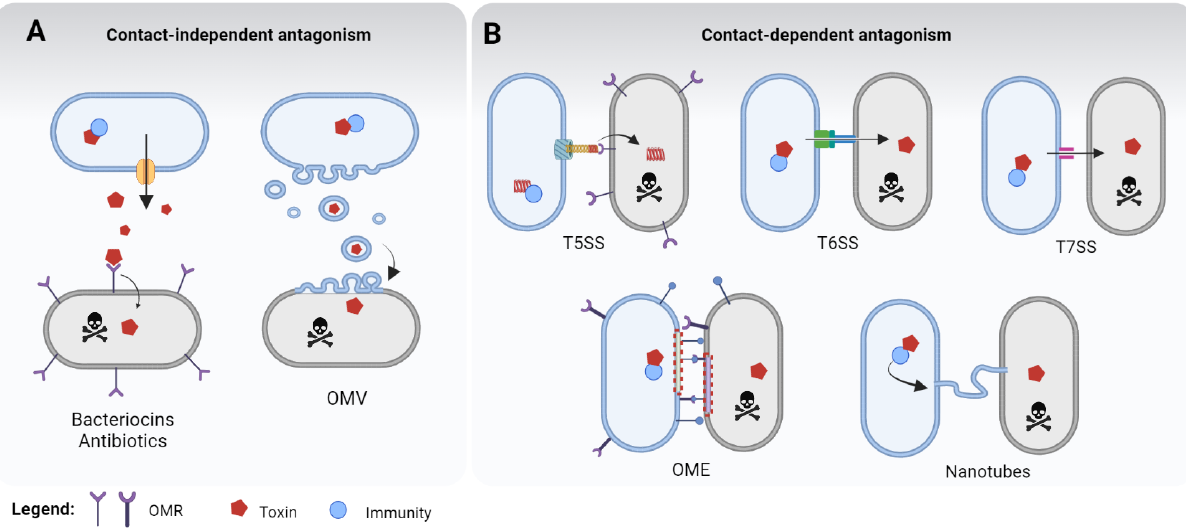
Figure 1 - Antagonistic strategies used by bacteria to counteract competitors. (A) Contact-independent antagonism. Colicins, microcins and antibiotics (red hexagon) reach targets by binding to OMRs (outer membrane receptors) prior to internalization. Autointoxication is prevented by immunity proteins, degrading/modifying proteins or efflux pumps (blue circles). Outer membrane vesicles (OMVs) deliver toxins to competing bacteria by membrane fusion. (B) Contact-dependent antagonism. T5SS presents CdiB anchored in cell membrane and CdiA extended. Receptor-binding domain (RBD) of CdiA interacts with OMR of targets to translocate CdiA-CT (red) into competitors. T6SS is anchored in the cell membrane and upon contraction propelled into target cell to deliver toxins (red hexagon). T7SS effectors (red hexagons) secreted into target cells upon contact. Outer membrane exchange (OME) events can transfer toxic proteins (red hexagons) that reach targets. Nanotubes are membrane extensions that connect two bacteria to transport toxins (red hexagons). Cognate immunity proteins produced by attacking bacteria are represented by blue circles. Created with